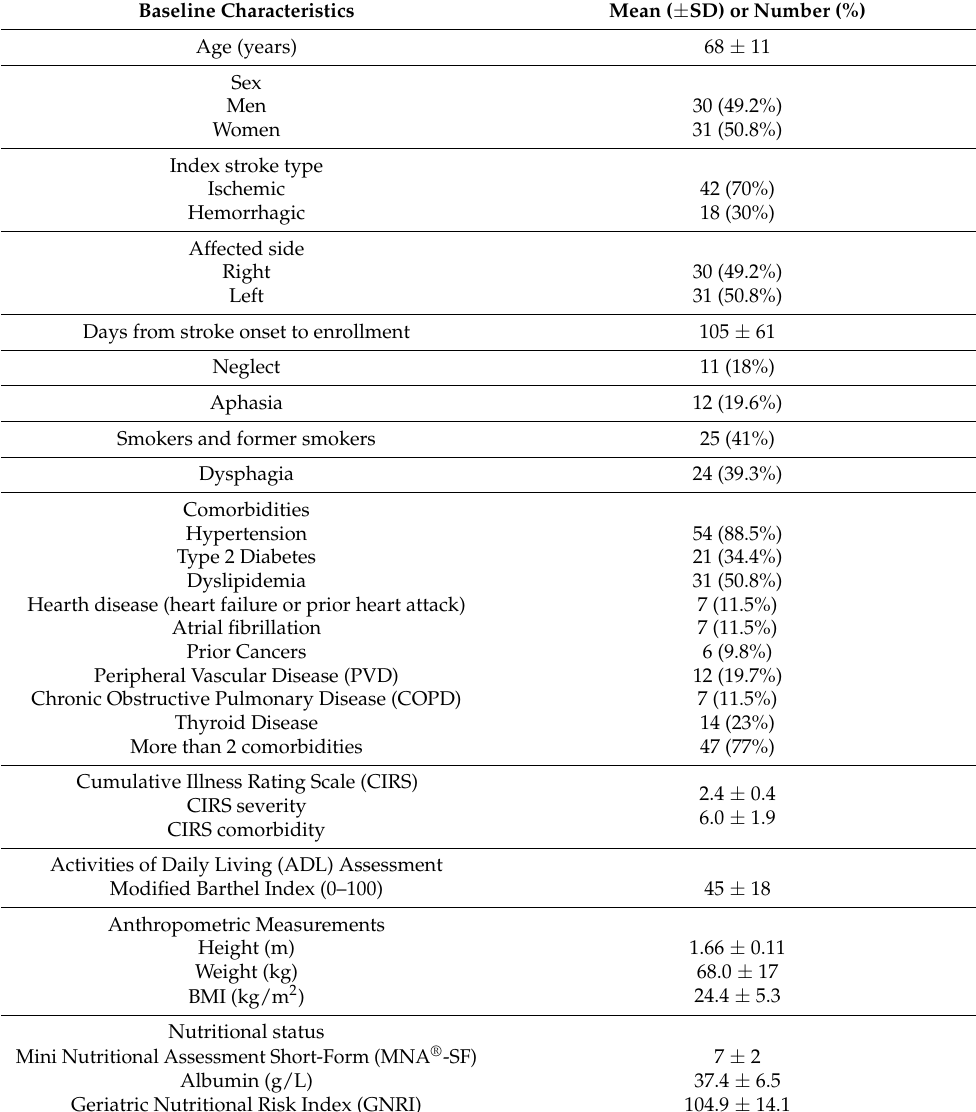
Table 1. Baseline characteristics of the sample ( n =